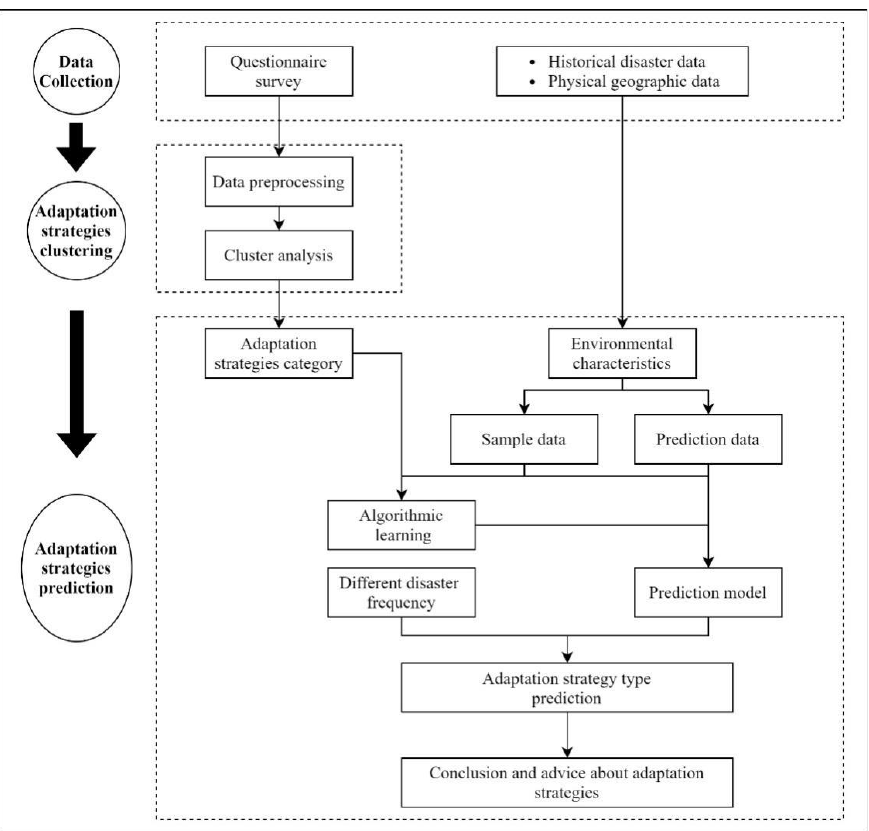
Figure 1. Methodology flowchart.